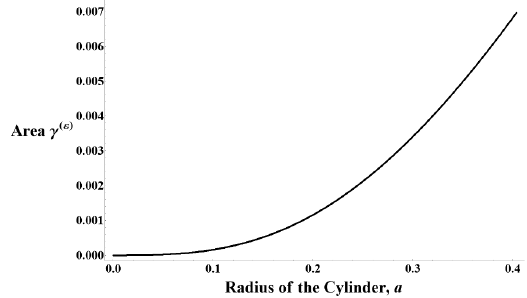
Figure 3 . γ ( ε ) ( a ) = 0 . 1633128 a 3 + . . . , from a = 7 . 96204 × 10 − 5 to a = 0 . 403790 , 5000 data